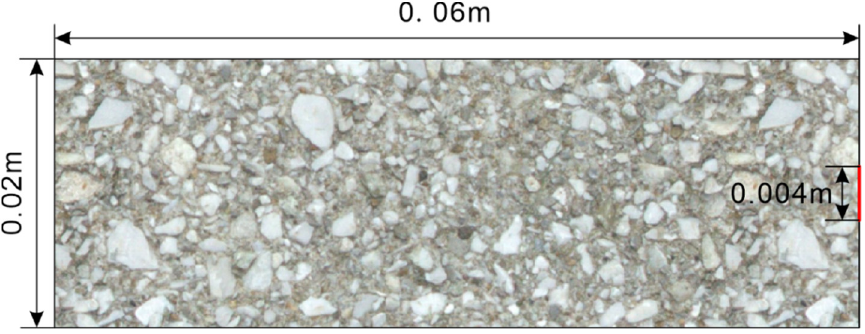
Figure 6. Cross-section of the simulation region.